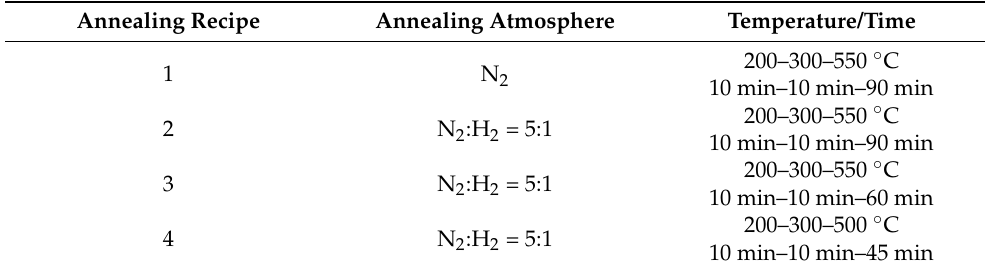
Table 2. Annealing